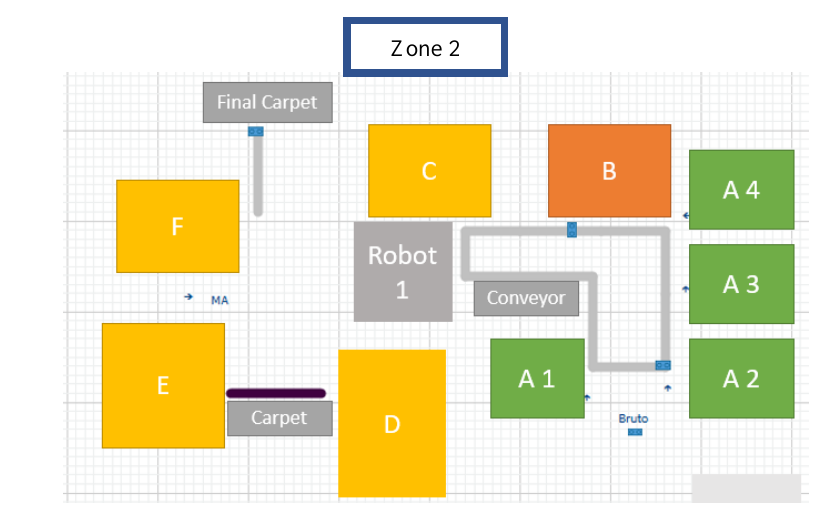
Figure 3. Layout 1 (Machine A and B together in Zone 2).